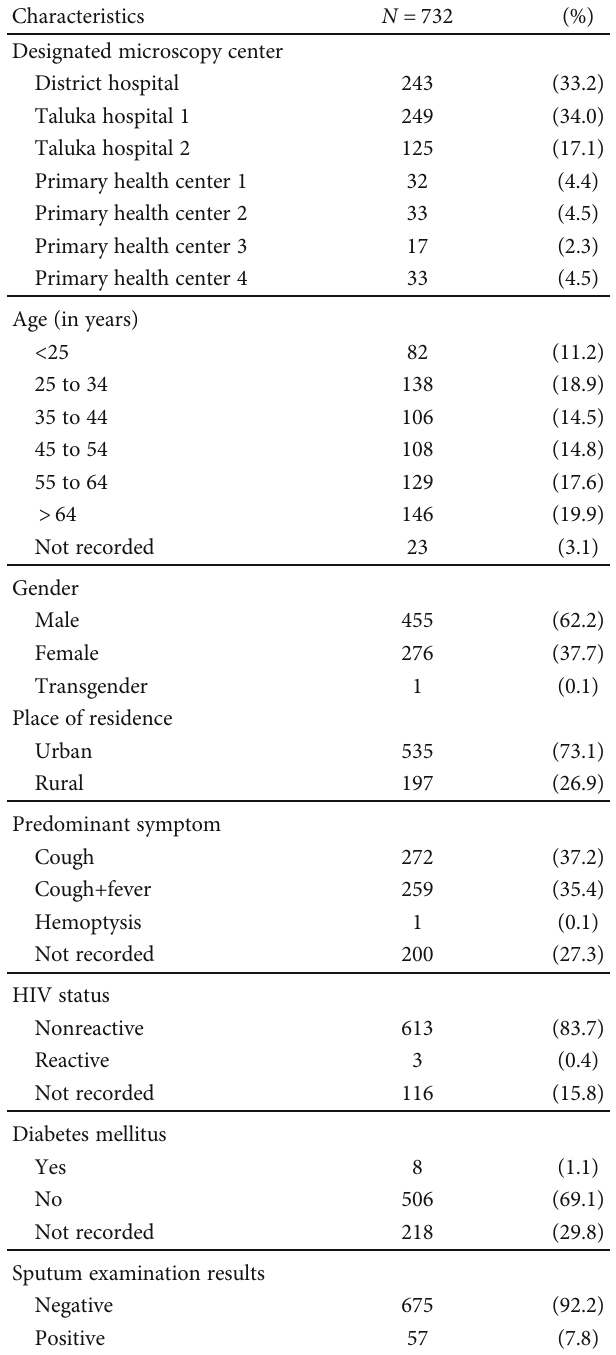
Table 1: Characteristics of persons with presumptive pulmonary TB attending seven selected designated microscopy centers in Chikkaballapur District during February-March